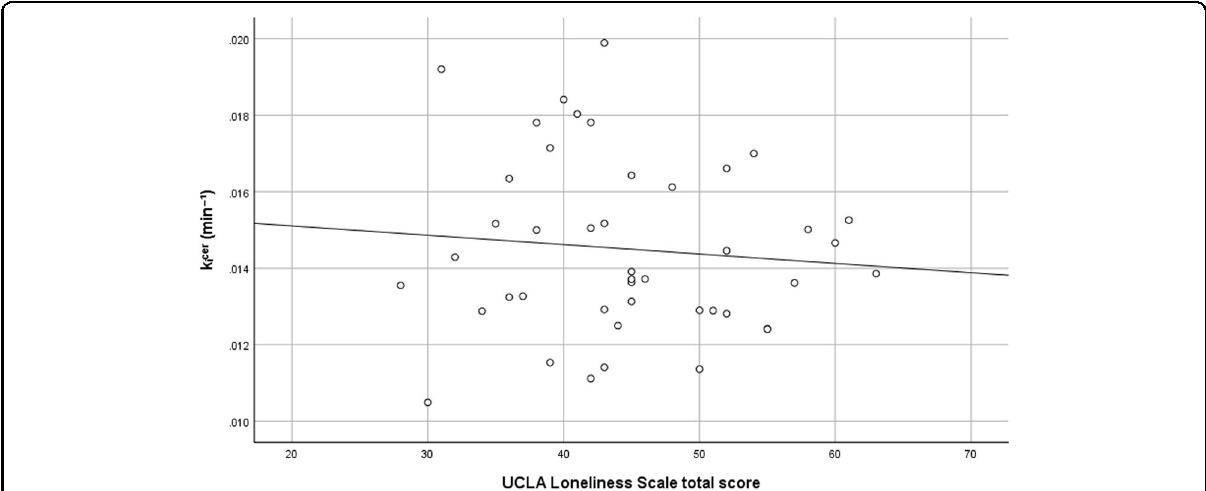
Fig. 3 Association between loneliness and striatal dopamine synthesis capacity in adults with autism spectrum disorder (ASD). Scatterplot shows the unadjusted relationship between total scores on the UCLA Loneliness Scale and presynaptic dopamine synthesis capacity ( k icer min -1 ) in the whole striatum.